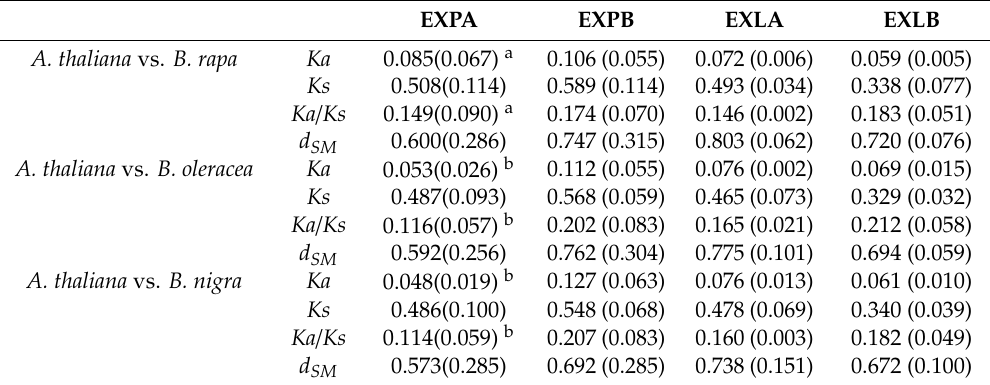
Standard deviation is shown in parentheses. Lower-case letters ( a and b ) indicate significant differences ( p < 0.05, Tukey test).